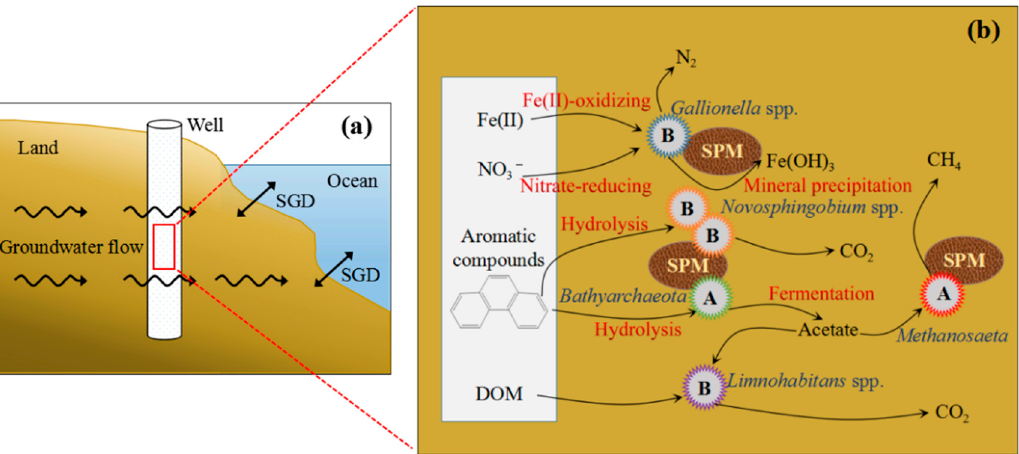
Figure 7. Schematic diagram of submarine groundwater discharge (SGD) ( a ). Main mechanism of nitrate, carbon and iron depletion contributed by the dominant microbial community of SGD in Qinzhou Bay ( b ). The “Suspended particulate matter (SPM)” in ovals represents suspended particulate matter. The “A” and “B” in the star with different colors represent the specific archaeal and bacterial groups, respectively.